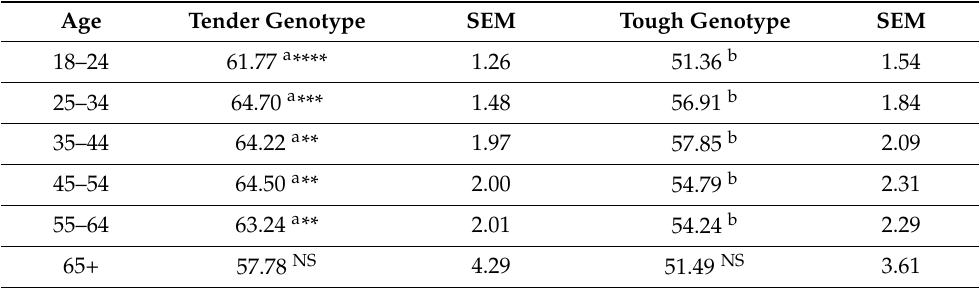
Table 2. MQ4 scores for Tough and Tender genotypes across consumer demographics.